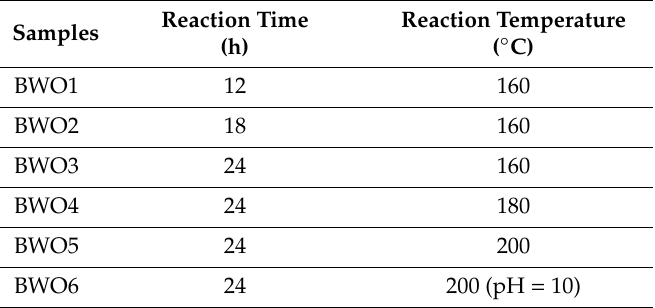
Table 1. Bi 2 WO 6 obtained at the different synthetic conditions.